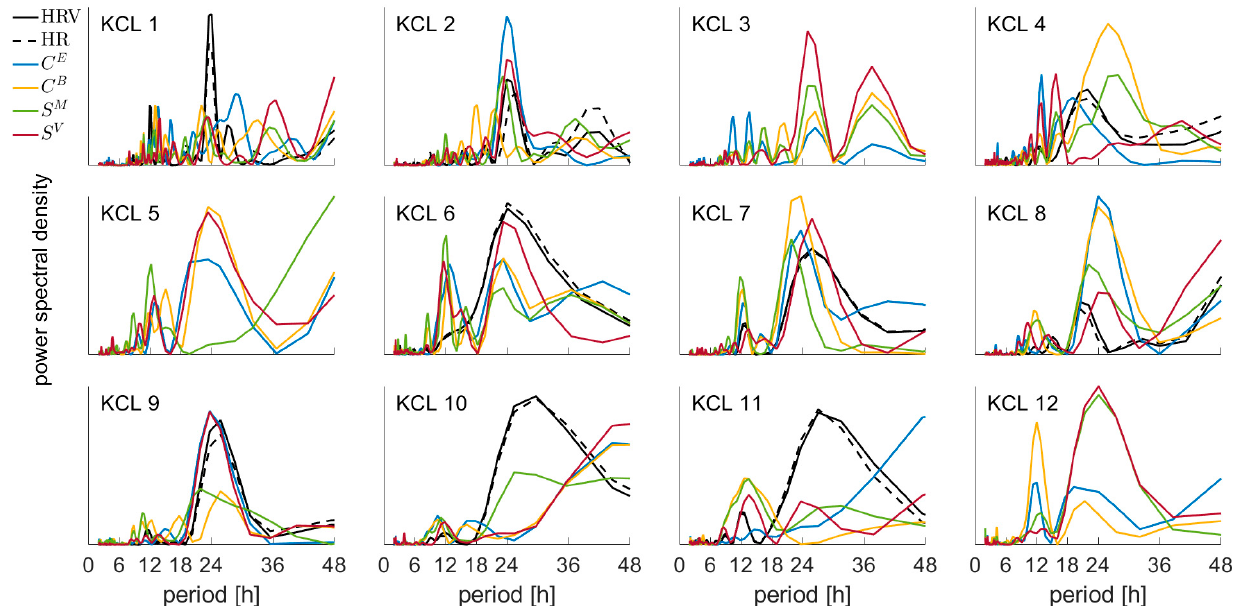
Figure 3. Periodograms of all the EEG and ECG metrics in the alpha frequency band. HRV: hear rate variability, HR: hear rate, C E : eigenvector centrality, C B : betweenness centrality, S M : mean strength, S V : variance of strength. Note that participants KCL 3, KCL 5 and KCL 12 do not have ECG metrics due to the absence of available ECG recordings (see Table 1).